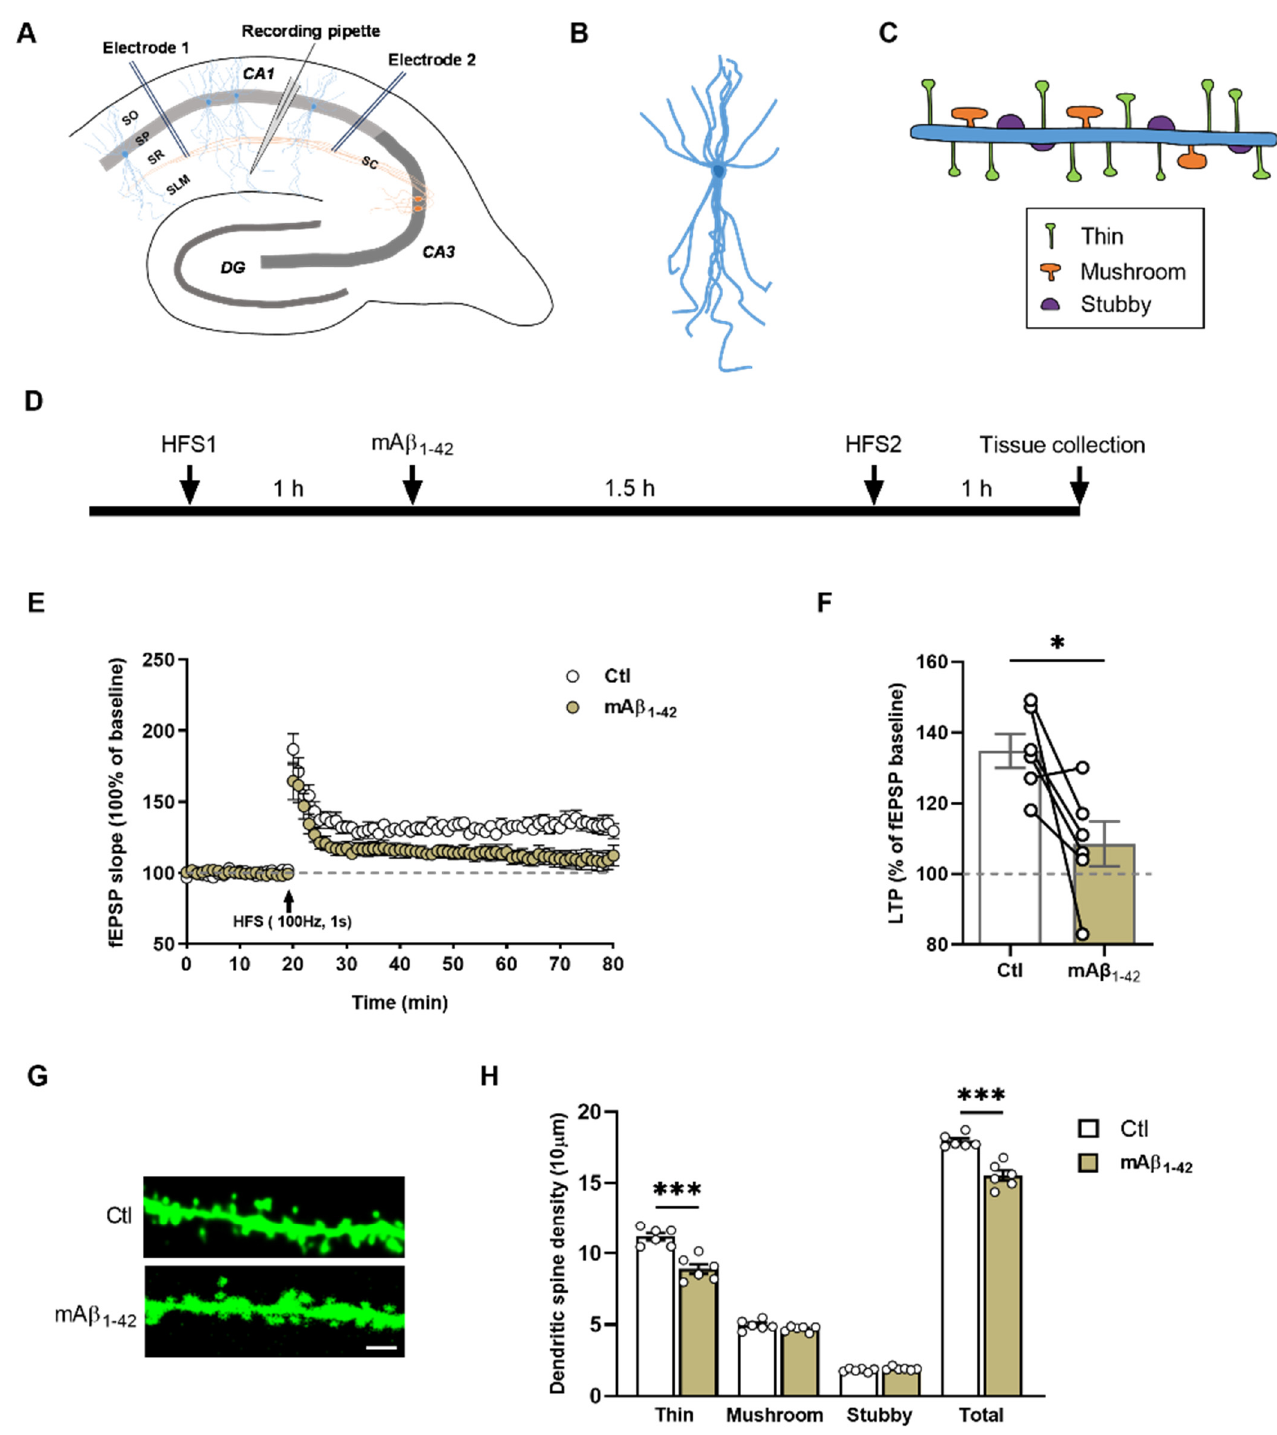
Figure 2. mA β 1–42 abolished LTP and reduced spine density. ( A ) Schematic showing the sagittal hippocampal slices. Anterograde or retrograde high-frequency stimulation (HFS, 100 Hz, 1 s) in the Schaffer collaterals pathway was triggered by two bipolar stimulation electrodes. The recording pipette was positioned in the stratum lacunosum-molecular layer of the CA1 region. ( B ) A schematic of CA1 pyramidal neuron. ( C ) Dendritic protrusions were classified and categorized as thin, stubby, and mushroom spines of CA1 pyramidal neurons. ( D ) Experimental design. ( E ) Normalized fEPSP values under control and mA β 1-42 application. ( F ) mA β 1-42 abolished LTP ( p = 0.0081). ( G ) Repre- sentative apical dendritic segments of CA1 pyramidal neurons of both groups. Scale bar = 2 µm. ( H )